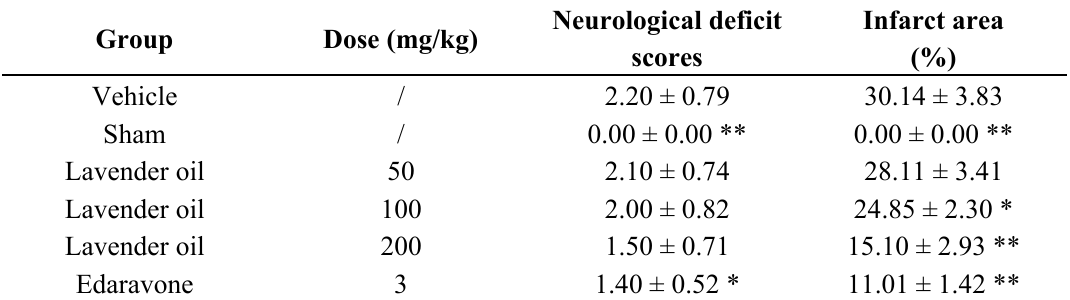
Table 1. Effects of lavender oil and edaravone on the neurological deficits and infarct area after 22 h of